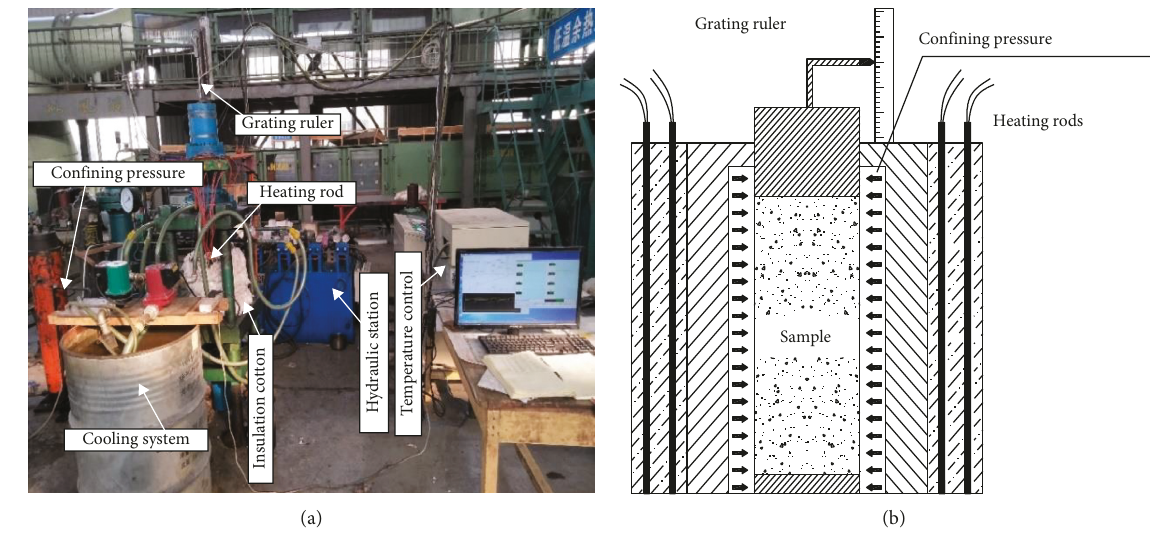
Figure 1: (a) Setup photograph and (b) schematic of the experimental device. Table 1: Parameters during heating experiment.